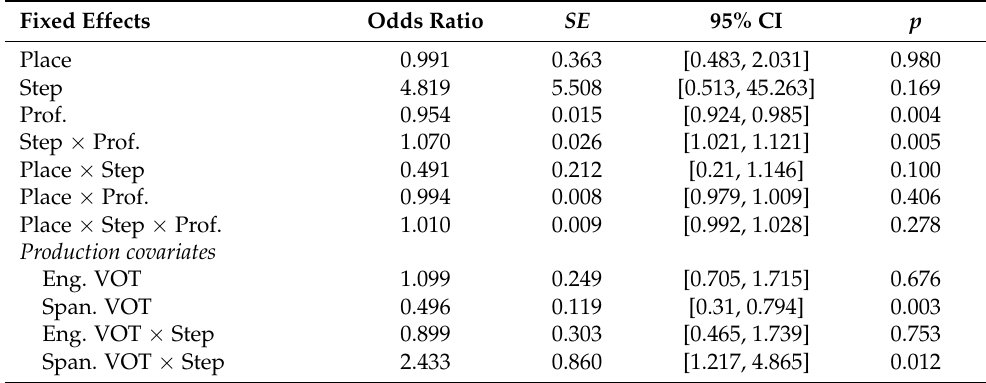
Table 6. Summary of ordinal mixed-effects model fit to the ratings for voiceless